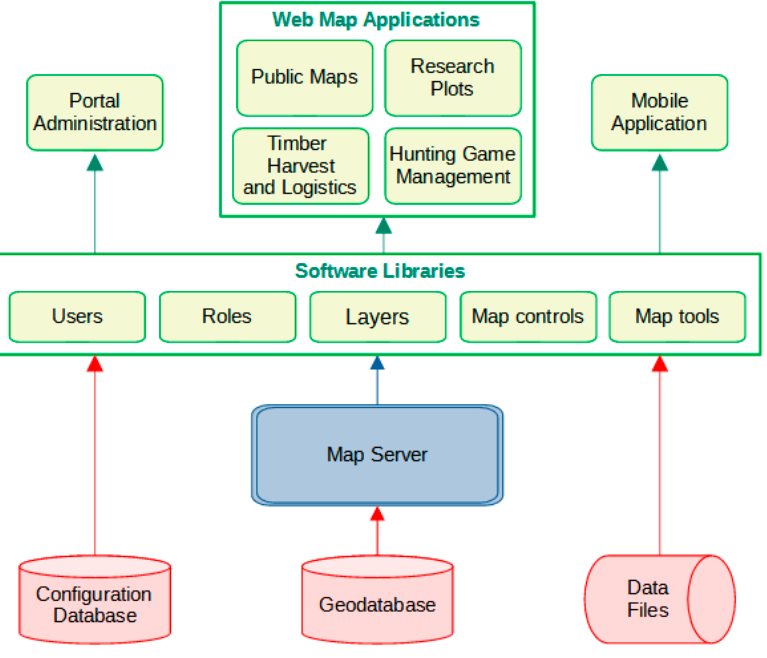
Figure 5. Architecture of the GIS portal.